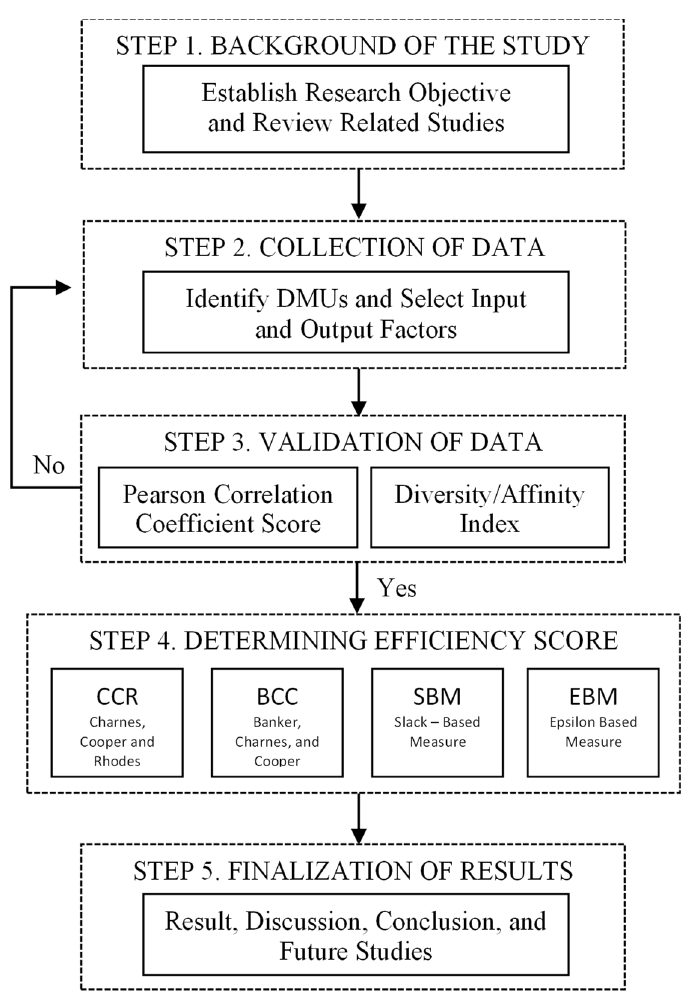
Figure 1. Procedure of the research.